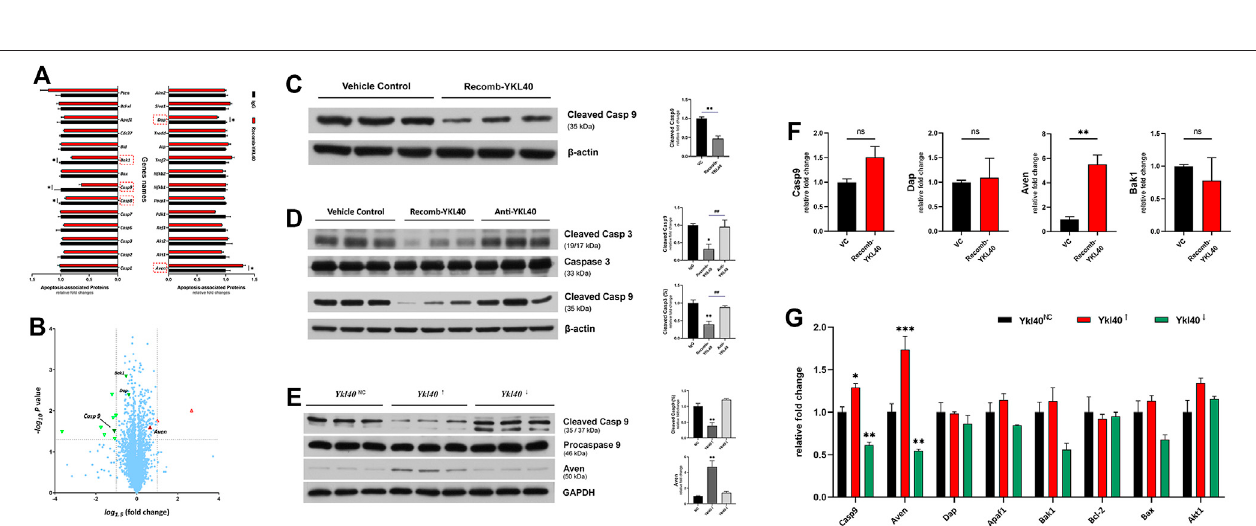
FIGURE6|(A,B) iTRAQ-based proteomicsanalysis. (A) Apoptosispromotors Casp9 , Casp8 , Bak1, and Dap weresigni fi cantlydown-regulatedbyYKL-40,while the apoptosis inhibitor Aven was signi fi cantly up-regulated. (B) Volcano Plot . Molecules down-regulated by YKL-40 are presented in the upper left area (green down arrow) while those up-regulated are shown in the upper right area (red up arrow), and those involved in apoptosis regulation are marked with up/down solid arrows. The mostsigni fi cant foldchange ( FC )ontheexpressionlevelofthesemoleculeswascausedby Casp9 ( FC (cid:1) 0.6411),followedby Aven ( FC (cid:1) 1.3006). (C,D) Caspase-9 expression levels detected in BMDM and aorta tissues of Ldlr − /- mice. YKL-40 signi fi cantly down-regulated the activation level of caspase-9. (E) In RAW264.7, which was upregulated by Ykl-40 , the activation level of caspase-9 was signi fi cantly lower than that in control group ( p (cid:1) 0.0054) while the expression level of Aven was signi fi cantlyhigherthanincontrols( p (cid:1) 0.0031).Therewasnosigni fi cantdifferenceincaspase-9activationandAvenexpressionlevelbetweenthe Ykl40 downregulated group and normal controls ( p > 0.05). (F) Genetic expression relative fold changes of Casp9 , Dap , Aven and Bak1. No signi fi cant difference was indicated on Casp9 in BMDM after being treated by YKL-40 recombinant protein, but Aven was signi fi cantly up-regulated. (G) Casp9 , Aven expression levels were signi fi cantly upregulated in Ykl40 upregulated RAW264.7 ( p (cid:1) 0.0154, p < 0.0001) and downregulated in the Ykl40 downregulated group ( p (cid:1) 0.0039, p (cid:1) 0.0037).